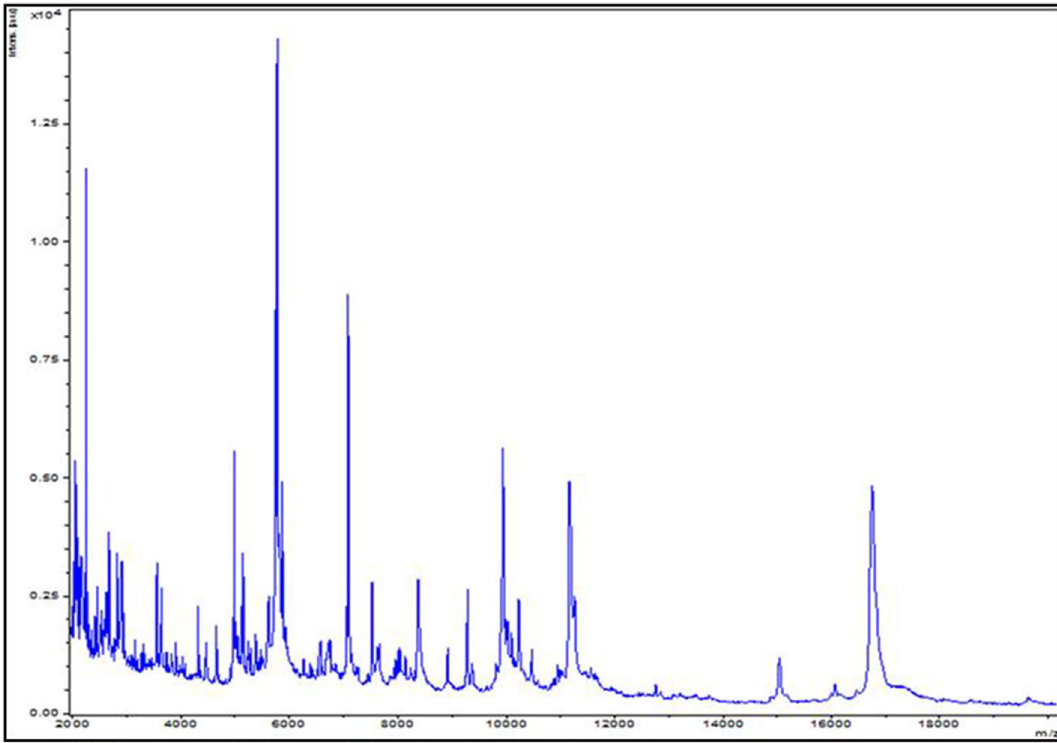
Figure 1. MALDI-TOF MS reference spectrum of Anaerococcus urinimassiliensis Marseille-P2143 T , the reference spectrum was generated by comparison of spectra from 12 individual colonies using the Biotyper 3.0